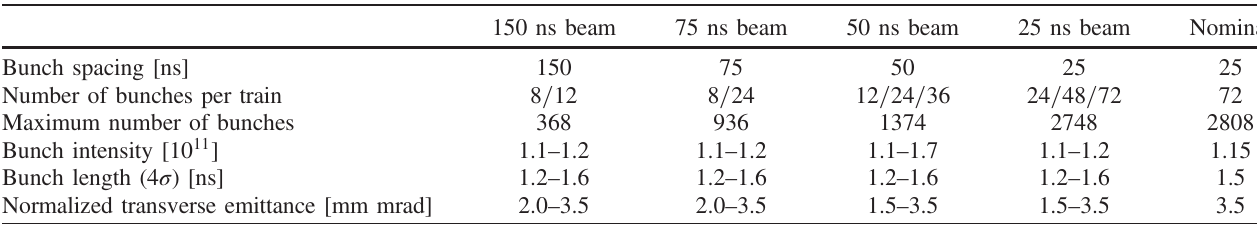
TABLE I. Summary of parameters at 450 GeV for different beams used during the LHC run